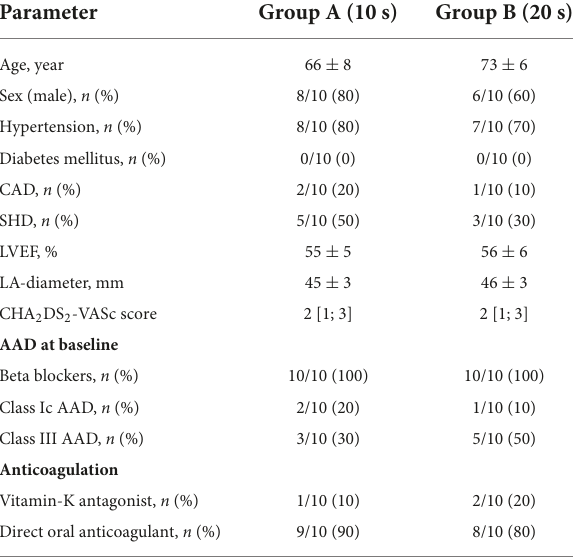
TABLE 1 Baseline characteristics.